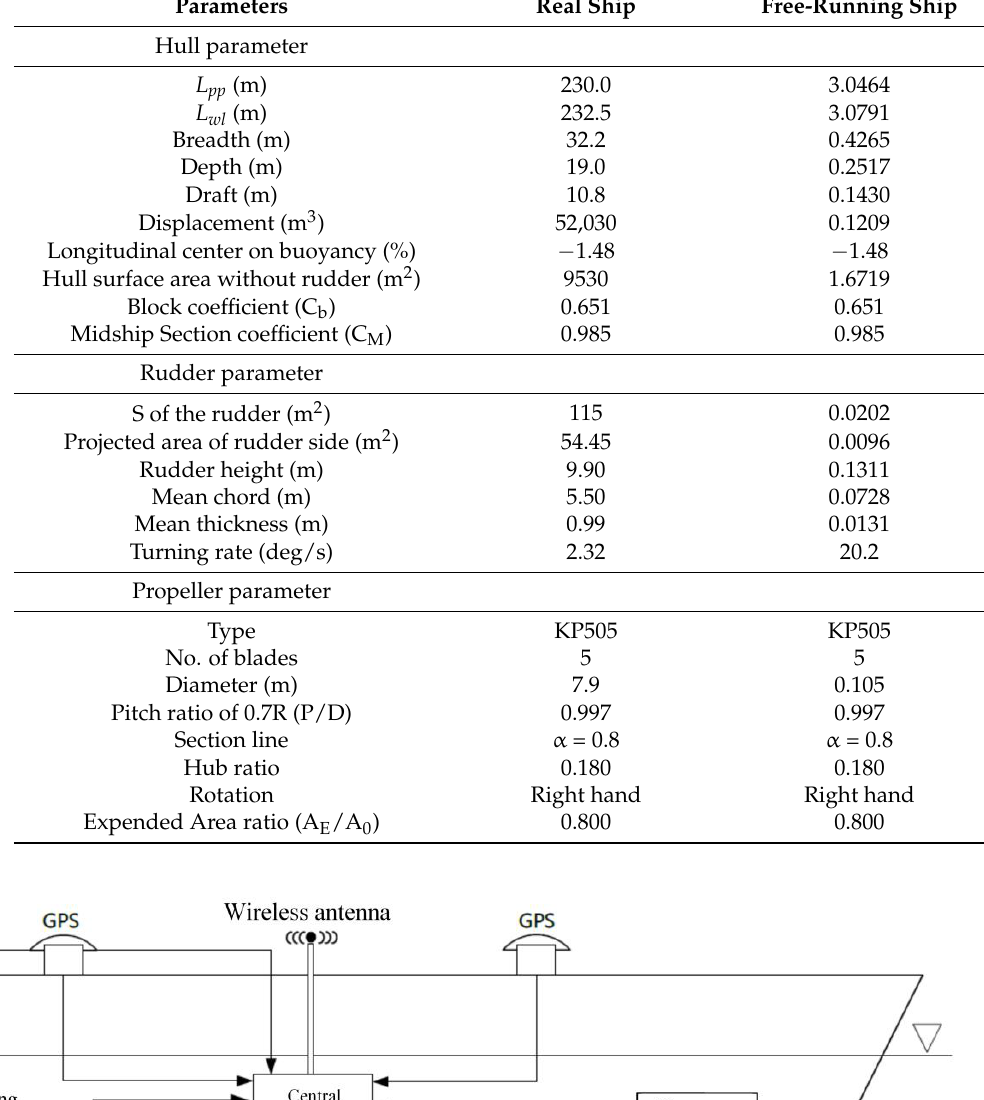
Table 1. Physical model parameters.